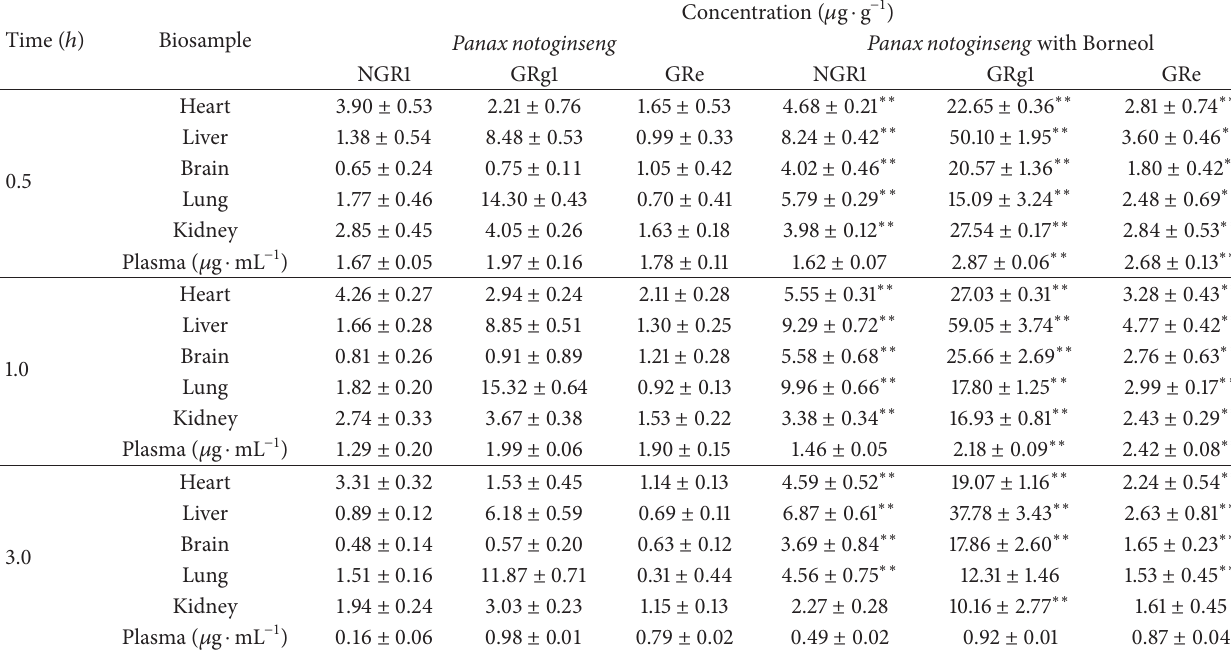
Table 5: Drug concentrations in rabbit tissues after administration of Panax notoginseng and Panax notoginseng combined with Borneol ( 𝑛 = 6